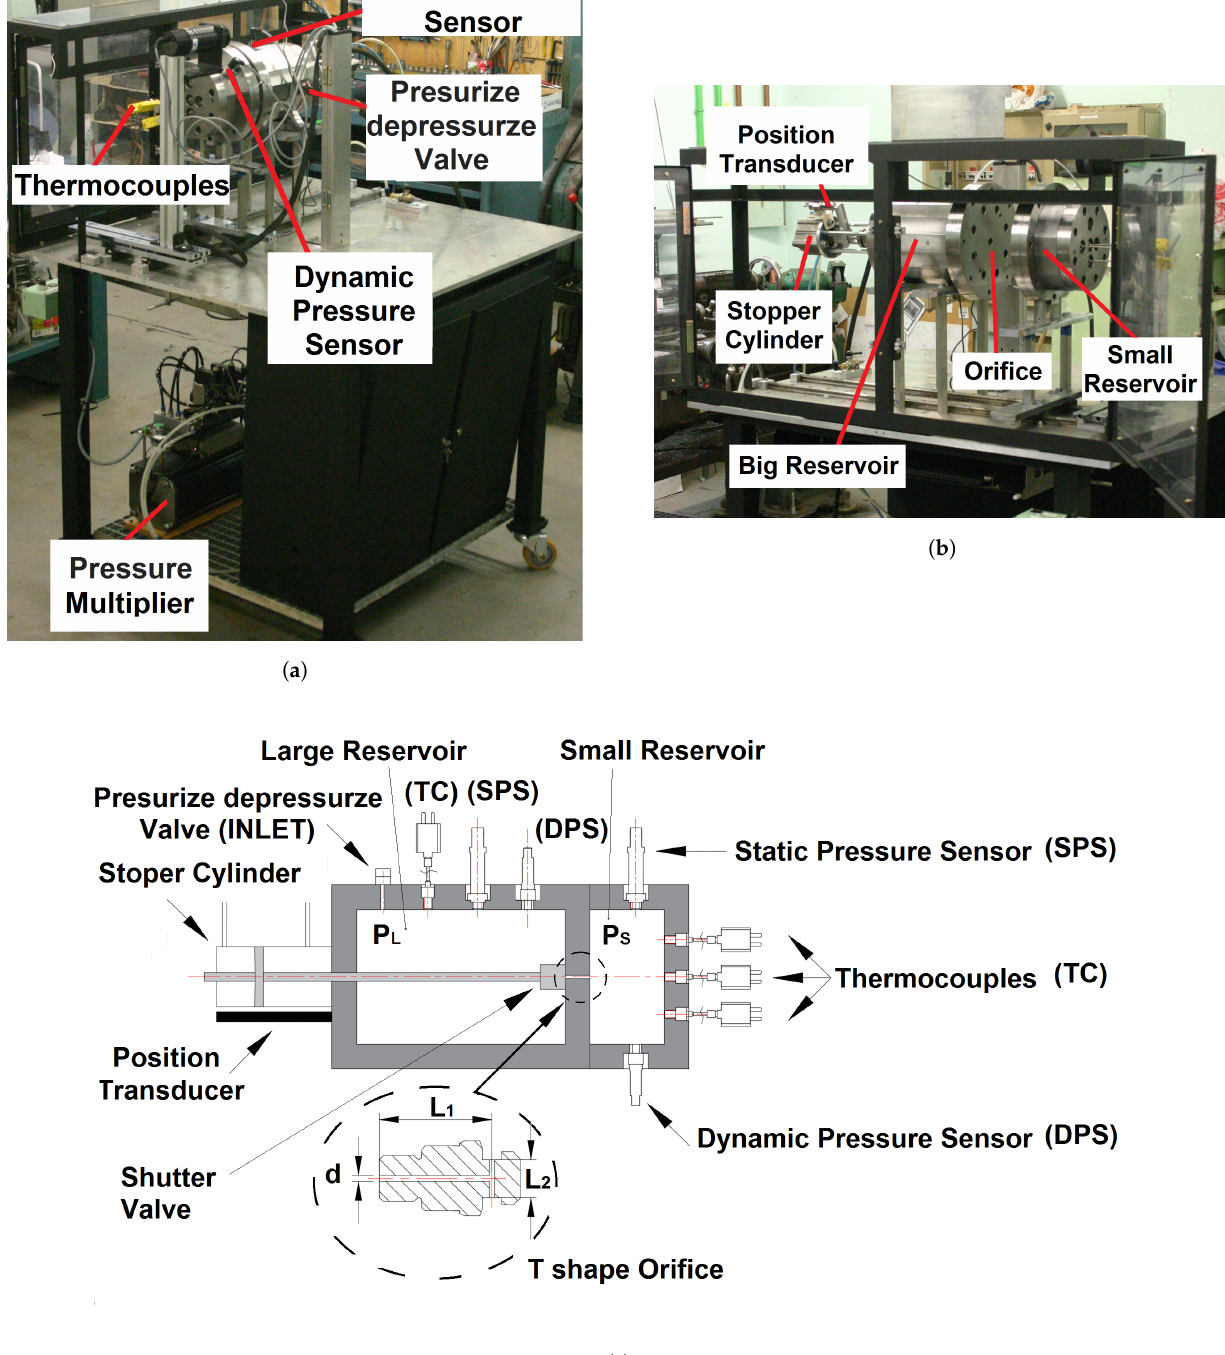
Figure 2. ( a ) Test rig main view. ( b ) The two reservoirs with their pressure and temperature transducers; ( c ) schematic view of the reservoirs and the transducers